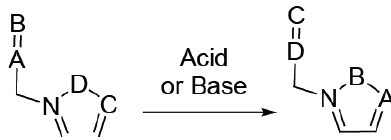
Figure 5 - Schematic representation of monocyclic rearrangement of